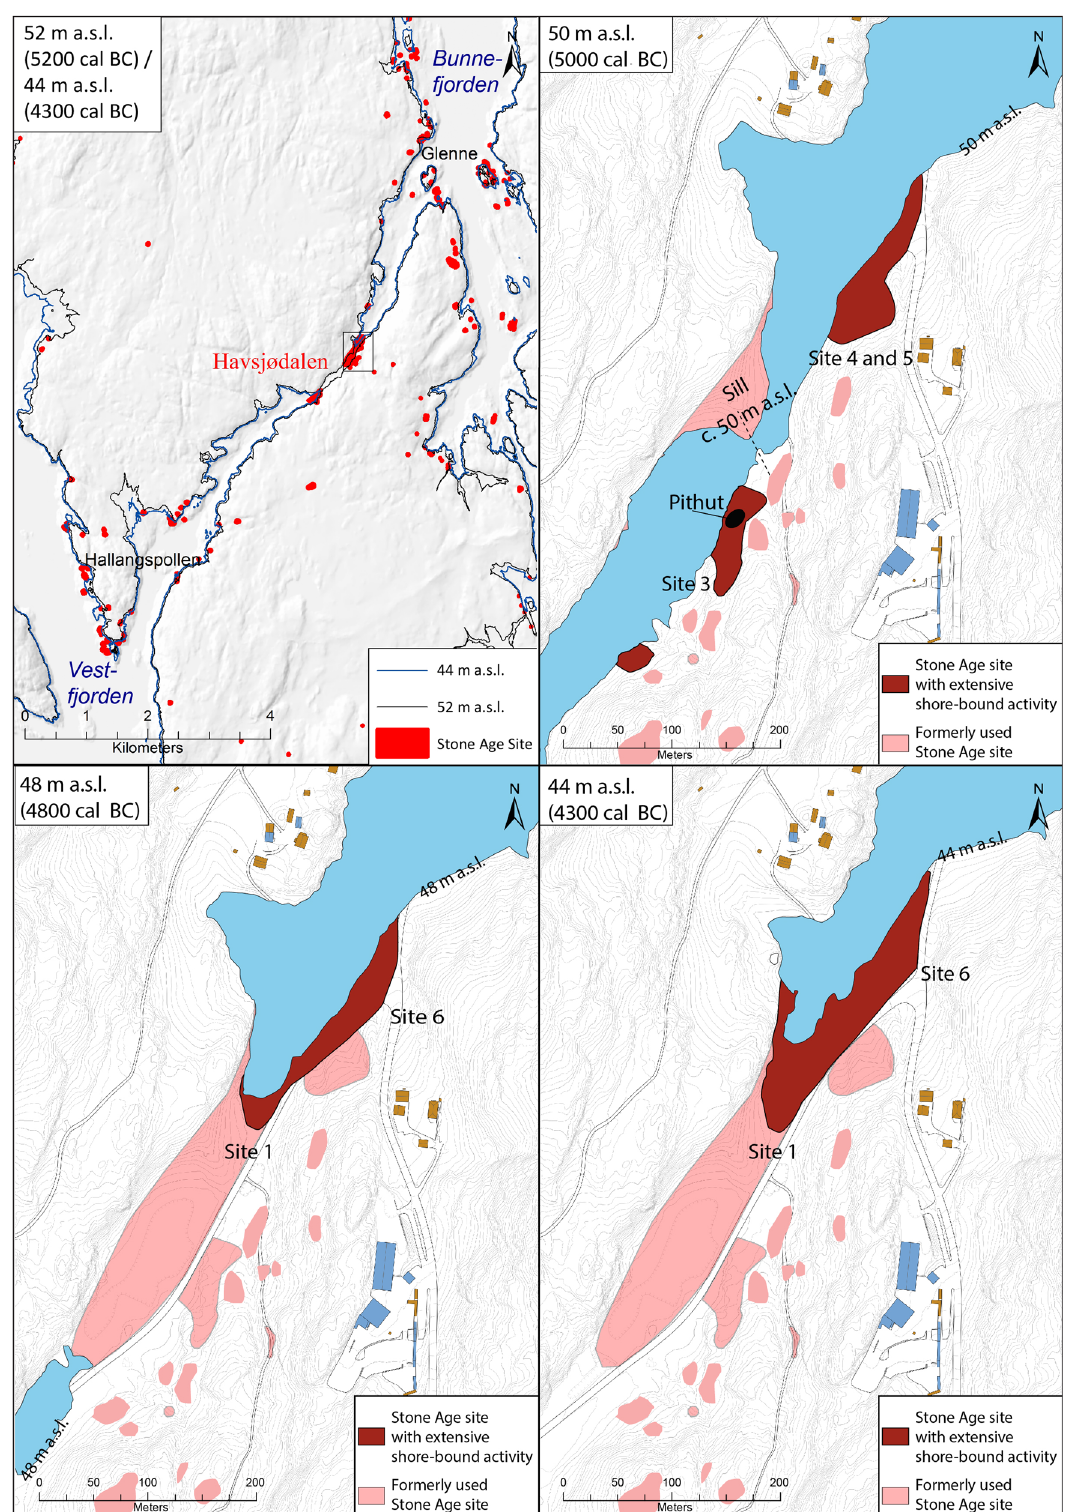
Figure 6: The changes in sea level and settlement activity in Havsjødalen from c . 5200 – 4300 cal BC. Map: Axel Mjærum,